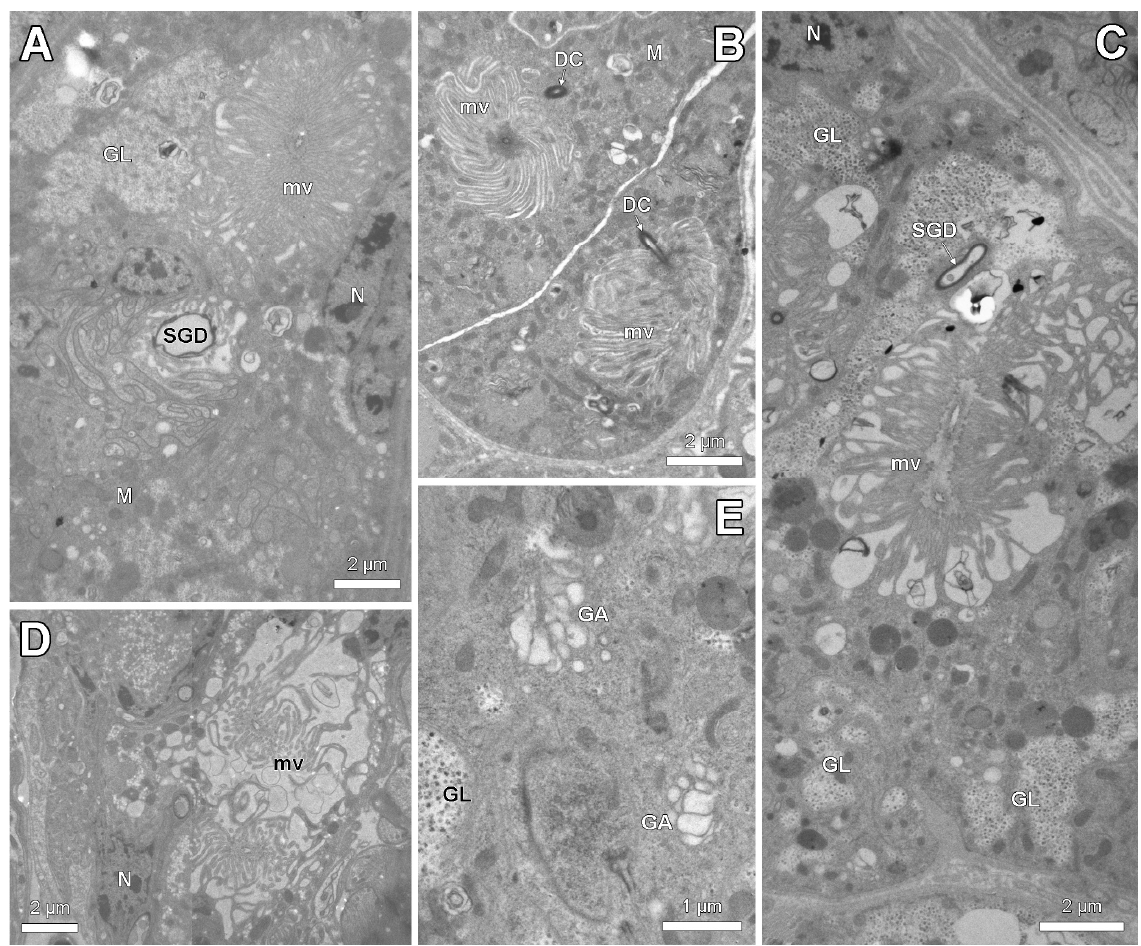
Figure 5. Electron micrographs of spermatheca gland of parthenogenetic queens. ( A ). General view showing spermatheca gland duct (SGD) and end apparatus with densely packed long microvilli (mv) in S. liukueiensis . Note accumulation of glycogen (GL). ( B ). Junction of duct cell (DC) with densely packed microvilli of end apparatus in S. rogeri . ( C ). Glycogen clusters and end apparatus with irregular microvilli in S. solifontis . ( D ). End apparatus with loosely arranged microvilli in S. emmae . ( E ). Detail of cytoplasm in S. solifontis , showing Golgi apparatus (GA) and glycogen. M: mitochondria, N: nucleus.